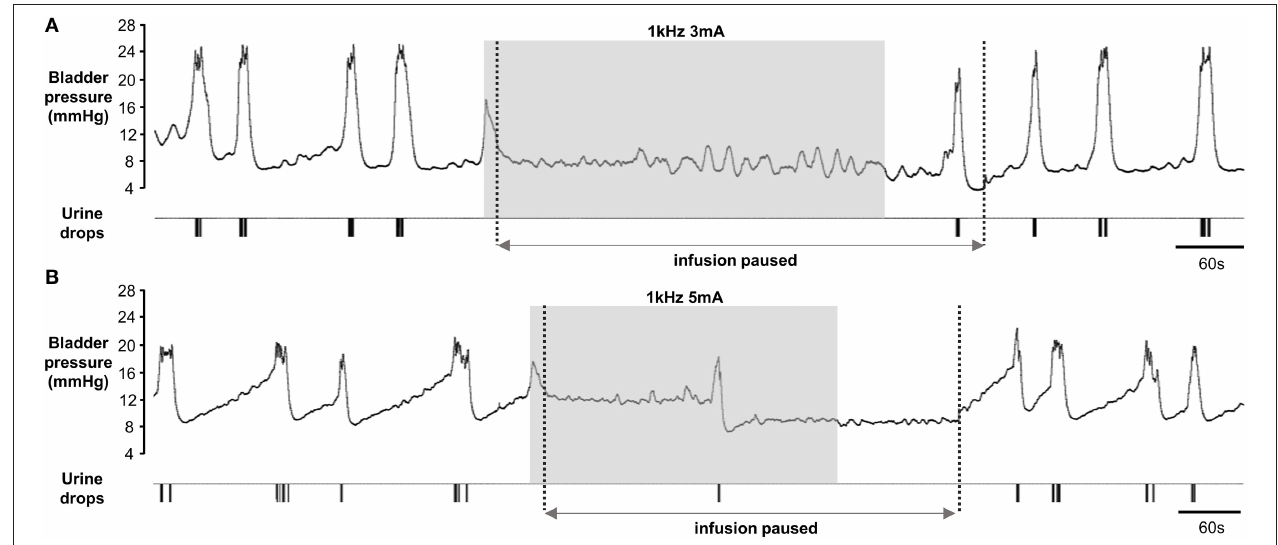
FIGURE 5 | Examples of effect of long periods of pelvic nerve stimulation in 2 rats. Once pelvic nerve stimulation (gray panel) had aborted the void infusion of saline into the bladder was subsequently paused (between broken lines) whilst the stimulation continued. (A) Continence was maintained for the full 5 min duration of the stimulation. (B) Voiding was deferred for 160s after onset of pelvic nerve stimulation. Note different intensities of pelvic nerve stimulation were required to inhibit voiding in the different animals.